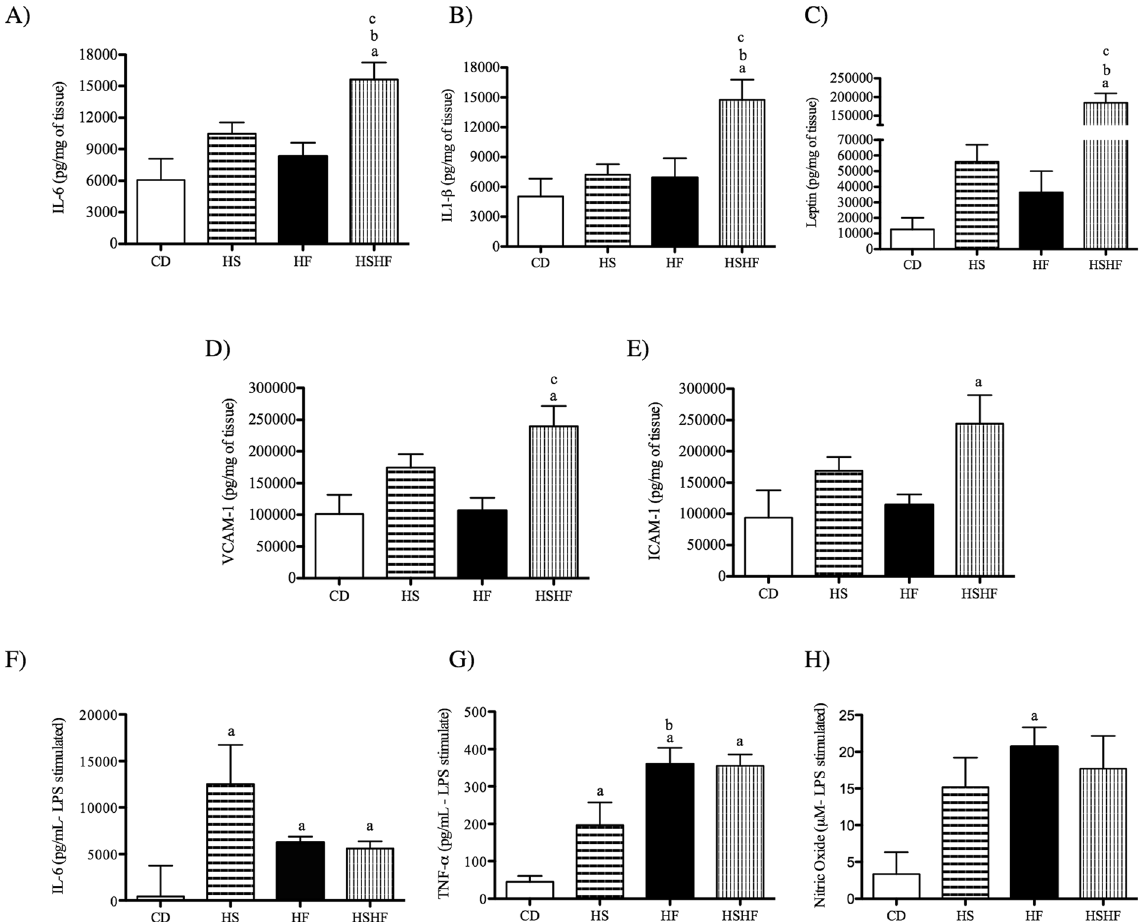
Figure 4. Content of IL-6 ( A ), IL-1 β ( B ), leptin ( C ), VCAM-1 ( D ) and ICAM-1 ( E ) by epididymal adipose tissue and of IL-6 ( F ), TNF- α ( G ) and nitric oxide ( H ) by LPS-stimulated peritoneal macrophages (1 × 10 6 cells) from C57BL/6 mice fed the control diet (CD) or obesogenic diets (high-sugar (HS), high-fat (HF) or high- sugar/high-fat diet (HSHF) for eight weeks. The results are expressed as the mean ± S.E.M. (n = 4–7/group). (a) P < 0.05 compared with CD, (b) P < 0.05 compared with HS, and (c) P < 0.05 compared with HF, using the one- way ANOVA and Tukey’s post-test. VCAM, vascular cell adhesion protein 1; ICAM, intercellular cell adhesion molecular 1; IL, interleukin; LPS, lipopolysaccharide from E . coli 055:B5 (2.5 μ g/mL for 24